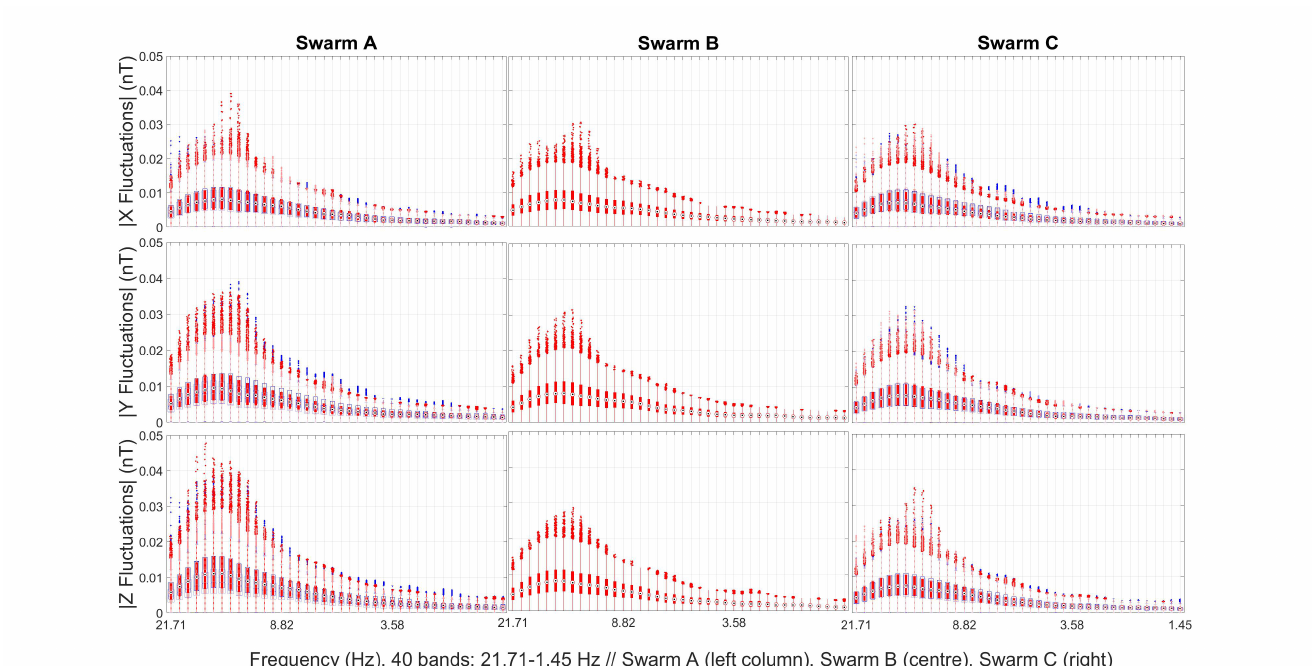
Figure 3. Combined CSES and Swarm investigation of the earthquake M6.5 (focal depth 20 km), Severo-Kurilsk, Russia, the box size is in both cases ± 10 degrees. Top : Distribution of CSES FGM1 magnetic field fluctuations for the X-, Y-, and Z-components grouped in individual frequency bands. The time span is ± 2 segments, i.e., in this case ∆ t = { − 1.36, − 0.37, − 0.31, 0.67, 2.65} days shift to the EQ at 2018-10-10T23:16:02. Bottom : Distribution of Swarm A/B/C VFM magnetic field fluctuations after wavelet analysis. The relative timing for the segments are t A ={ − 1.96, − 1.46, 0.54, 1.01} days, t B = {0.85} days (only one post crossing), and t C ={ − 1.97, − 1.46, 0.54, 1.01} days. The colour coding is the same as in Figure 2, i.e., {pre/post} is {blue/red} with gradually desaturation (fading) for larger ∆ t (interval between crossing and event). Geomagnetic activity, derived from the Disturbance Storm Time (Dst) index, is | Dst | ≤ 41 nT for the whole